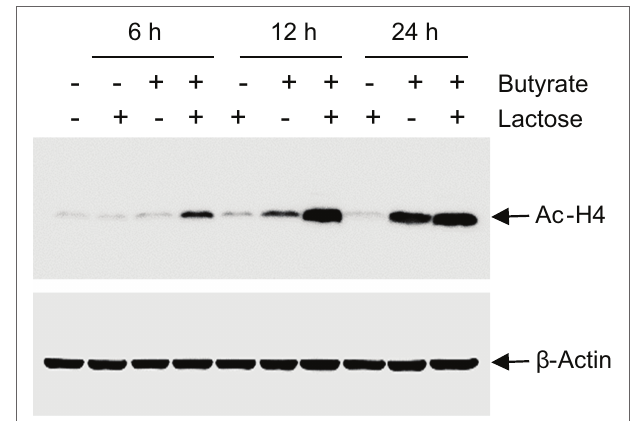
FIGURE 9 | Acetylation of histone H4 in response to butyrate and lactose. Chicken HD11 cells were treated with 0.2 M lactose with or without 2 mM sodium butyrate for 6, 12, or 24 h, followed by Western blot analysis for acetylation of histone H4. β -actin was also probed to show an equal amount of protein loading in each lane. The results are a representative of two independent